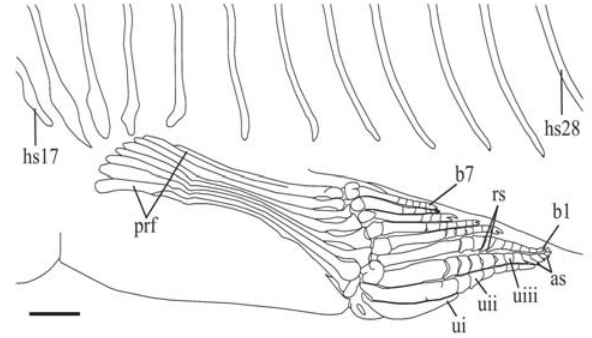
Fig. 2. Tatia jaracatia , paratype, MZUSP 98251, adult male, anal fin in left lateral view. Abbreviatons: as, antrorse spines; b1, branched first ray; b7, branched seventh ray; hs17, hemal spine 17; hs28, hemal spine 28; prf, proximal radials fused; rs, retrorse spines; ui - uiii, unbranched first to third ray. Scale bar = 1 mm.